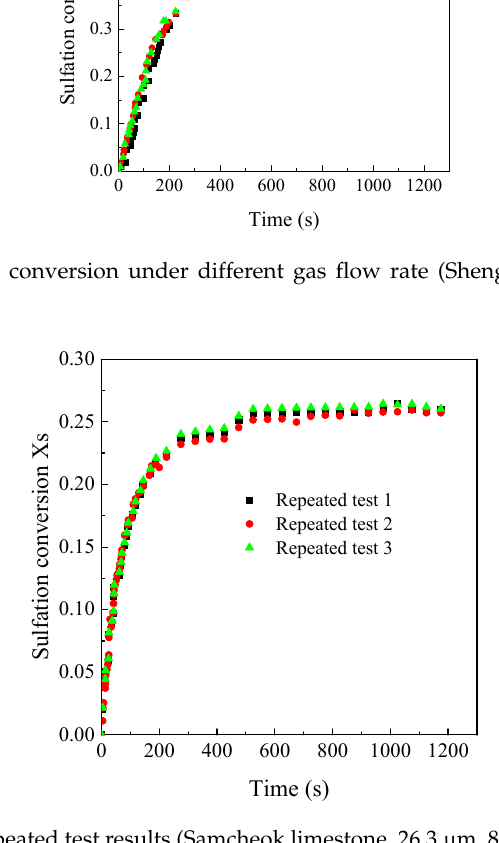
Figure 5. The repeated test results (Samcheok limestone, 26.3 μ m, 850 °C, 1000 ppm).